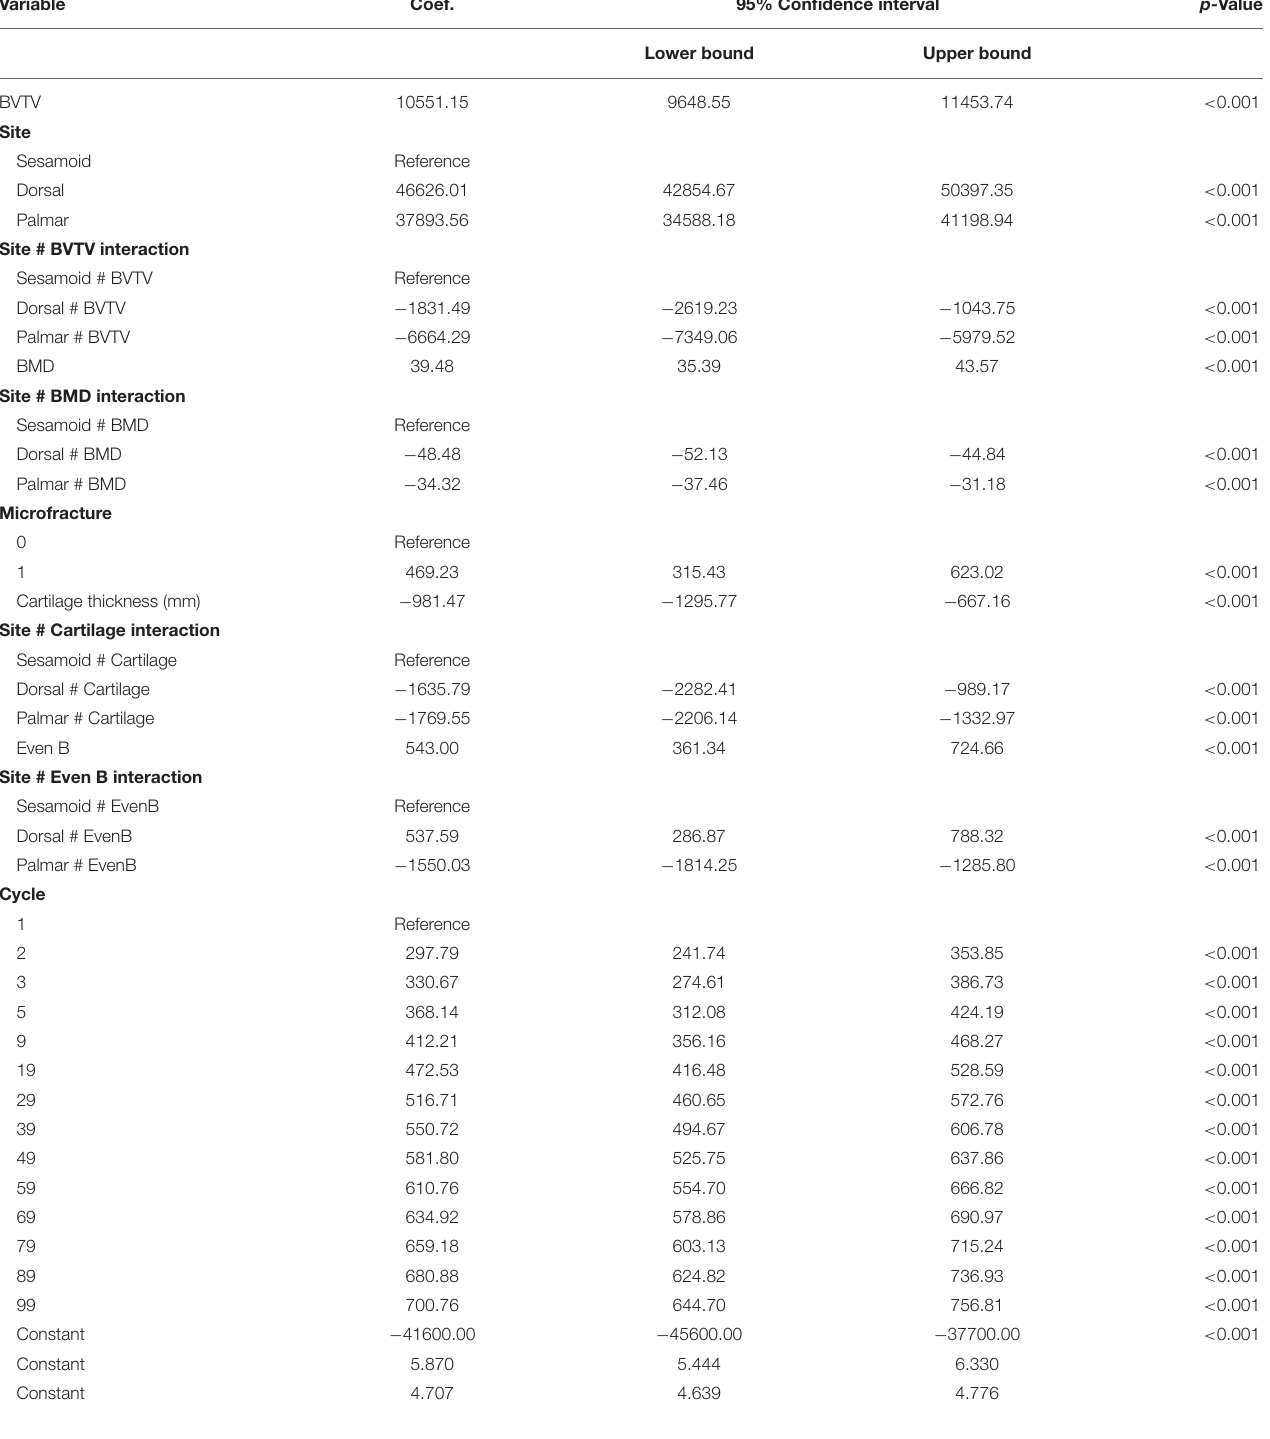
TABLE 3 | Multivariable mixed effects linear model estimated regression coefficients (Coef.), their 95% confidence intervals, and alpha level ( p -value) of factors associated with total ∼ 10mm thick cartilage-bone specimen stiffness ( n = 420) in three sites (dorsal MCIII, palmar MCIII, and proximal sesamoid) within the metacarpophalangeal joint of n = 10 Thoroughbred